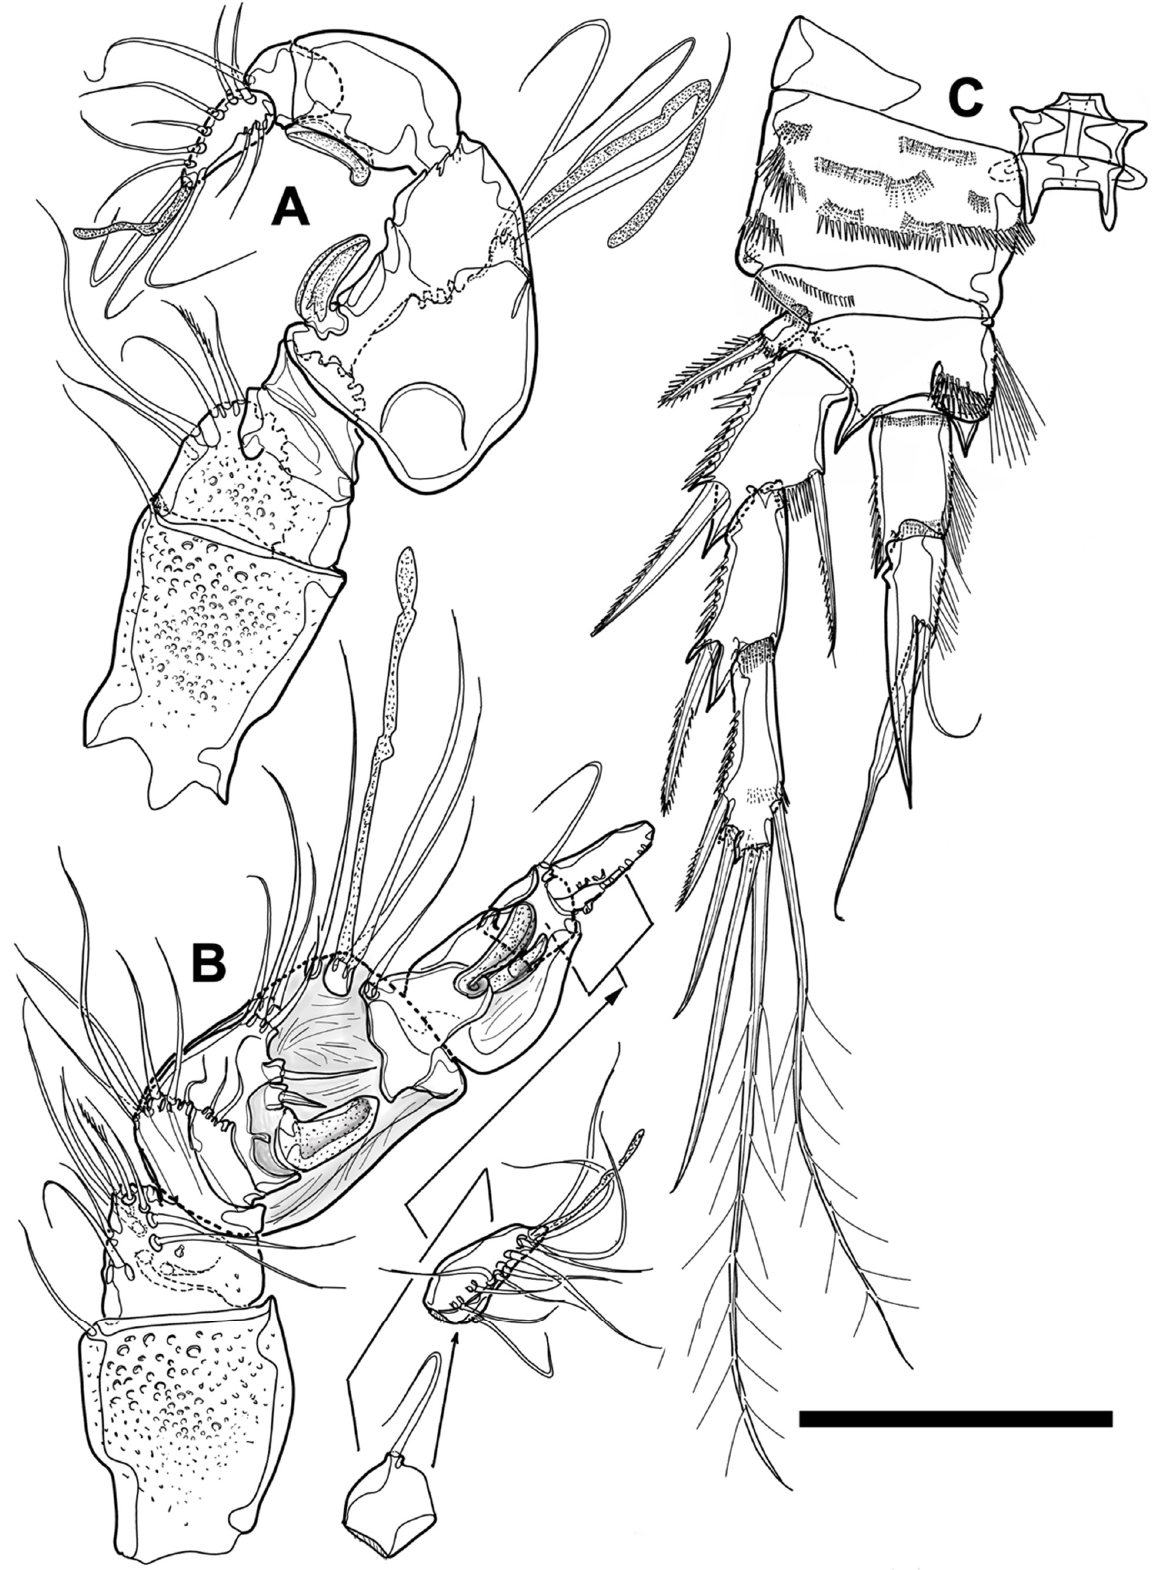
Figure 36. Line drawings of Phyllopodopsyllus similis sp. nov. male (paratype 25): ( A ) antennule, lateral; ( B ) antennule, dorsal; ( C ) P2. Scale bar: 50 µm.